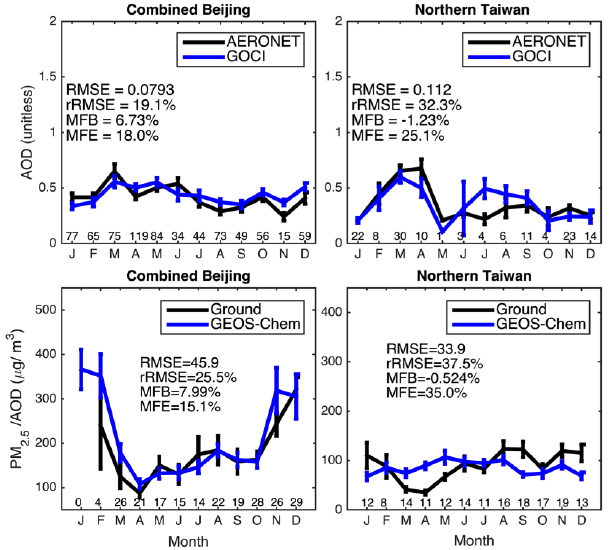
Figure 2. Top: monthly time series of AOD from AERONET and GOCI for January–December 2013. Numbers above the x axis de- note the number of coincident hourly observations in each month. Bottom: monthly averages of PM 2 . 5 / AOD from ground measure- ments and the GEOS-Chem simulation at AERONET sites. The ground-based ratio is sampled from daily ground PM 2 . 5 coincident with AERONET AOD for January–December 2013. The GEOS- Chem simulation is for May 2012–April 2013, noncoincident with the ground-based ratio for May–December 2013. Numbers above the x axis denote the number of daily ground-based observations in each month. Error bars represent standard errors. Statistics are root mean square error (RMSE), relative root mean square error (rRMSE), mean fractional bias (MFB) and mean fractional error (MFE).